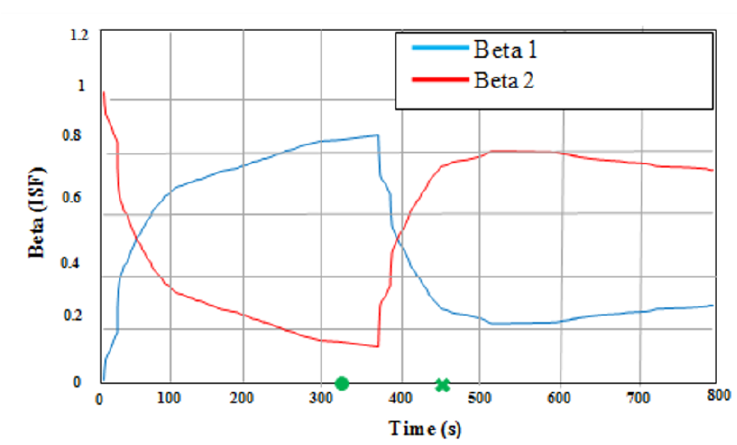
Figure 10. Reference Trajectory and Reference Landmarks.